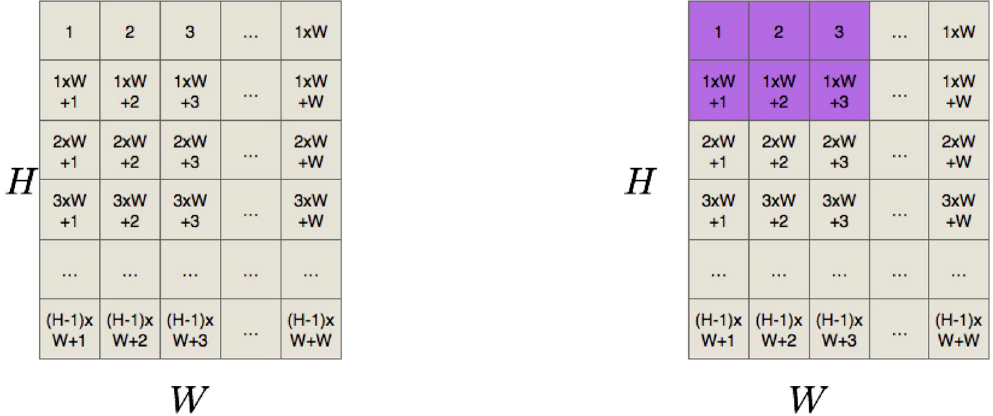
Fig 3. First step of the P&C methodology. a) Grid inside of the strip and b) Valid position for an item with dimensions 2 × 3 with its top-left corner at tile